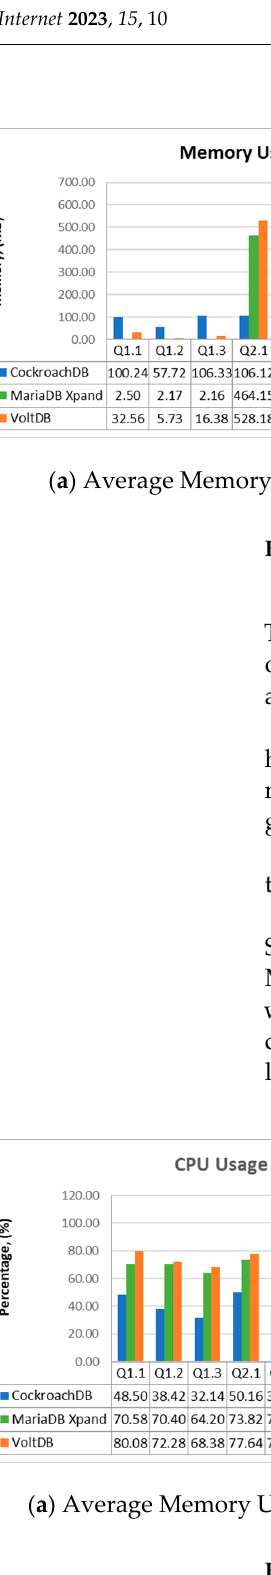
Figure 14. Sum of queries between SF = 1 and SF = 10. In summary, VoltDB presents the best results of query execution time for all SSB que- ries. Its scalability should also be noted: when the dataset size increases by 10 times, the query execution time has only an increment of 2.1 times. 6. Discussion The main purpose of this paper is to explore the topic of NewSQL databases and to provide an analysis of the best databases, using OSSpal methodology and a standard benchmark (SSB) to evaluate their performance and scalability. The study conducted shows that using OSSpal methodology, MariaDB Xpand achieves 4.16 points, VoltDB achieves 4.10 points, and CockroachDB achieves 3.99 points, as shown in Figure 15. These values are only determined by analyzing and selecting key functionalities and qualities that each database presents, which can bias the results.